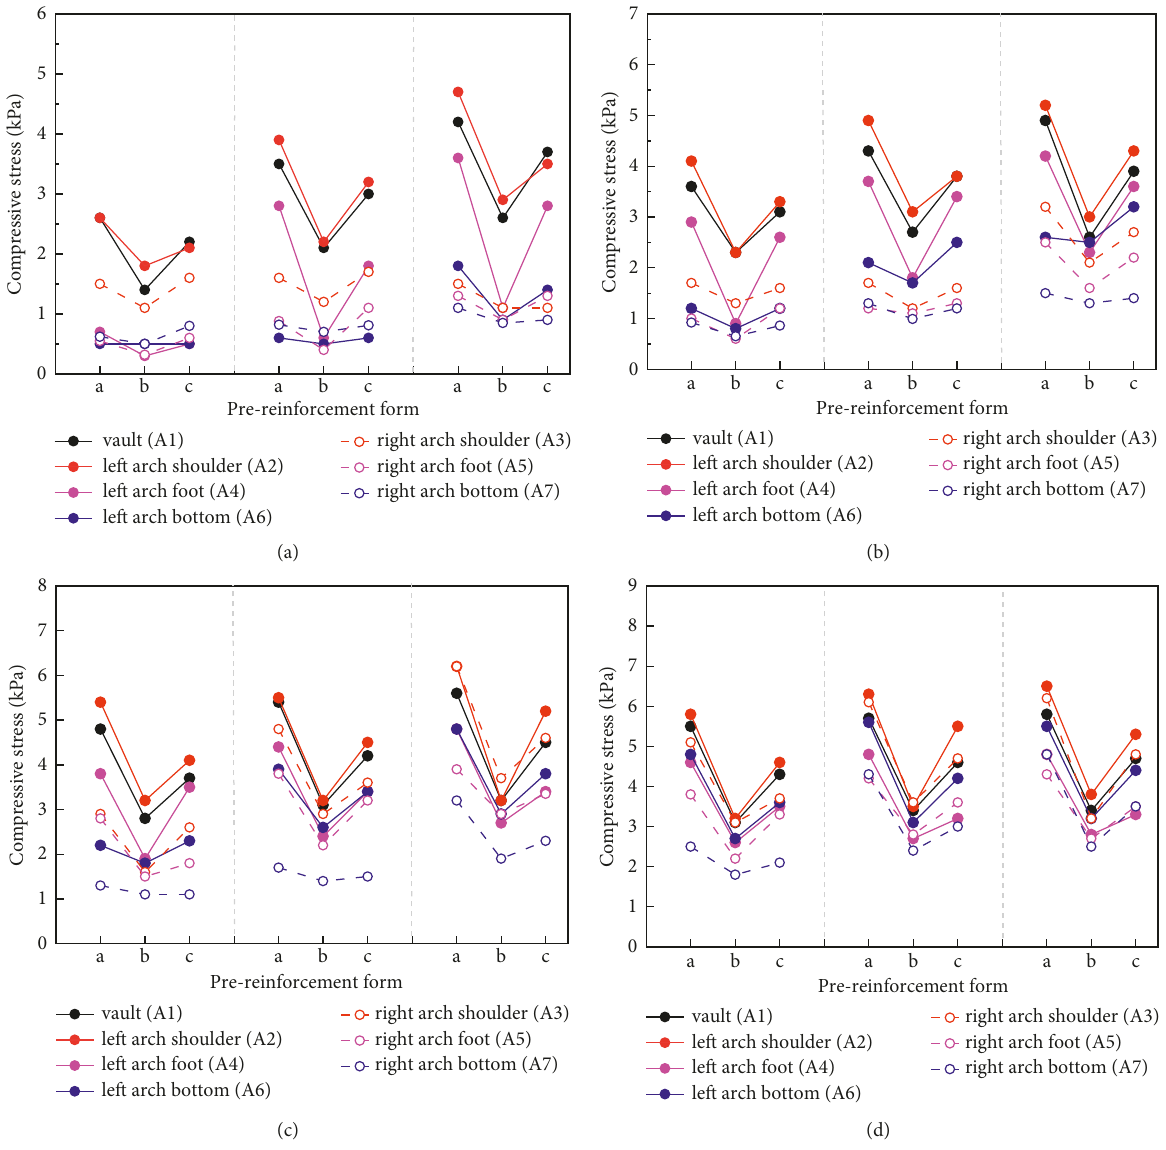
Figure 8: Surrounding rock stress variation of the CRD-4 excavation method under different pre-reinforcement forms. (a) Section I excavation. (b) Section II excavation. (c)Section III excavation. (d) Section IV